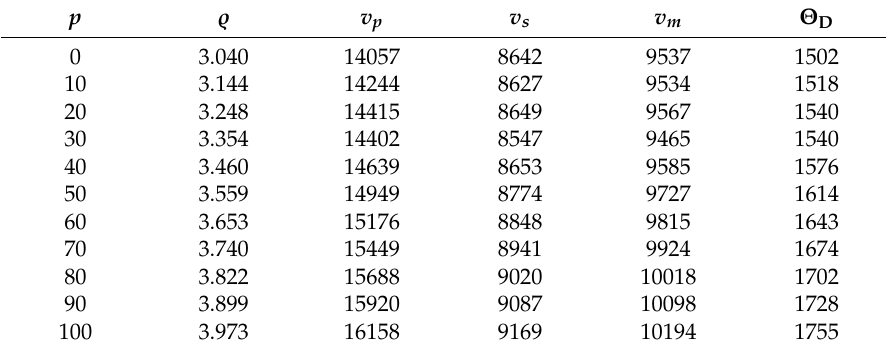
Table 4. The calculated density ρ ( g/cm 3 ), sound velocities (m/s), and Debye temperature ( K ) of Pnma -BN. p ρ v p v s